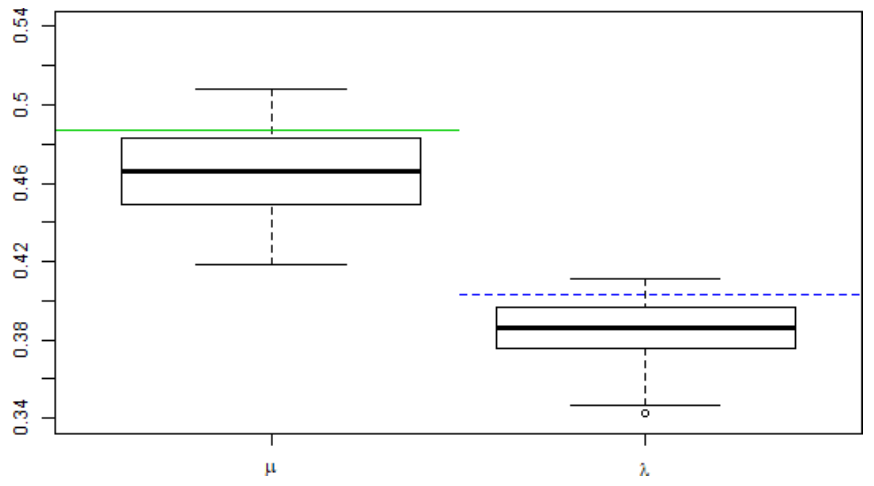
Figure 5. Comparisons of parameter estimates between simulations and observed data for the third microfire. The box plots represent samples of estimates based on 100 simulations of the fitted stochastic spread model. The solid horizontal line represents the estimated value of µ and the dashed horizontal line represents the estimate of λ , based on the observed